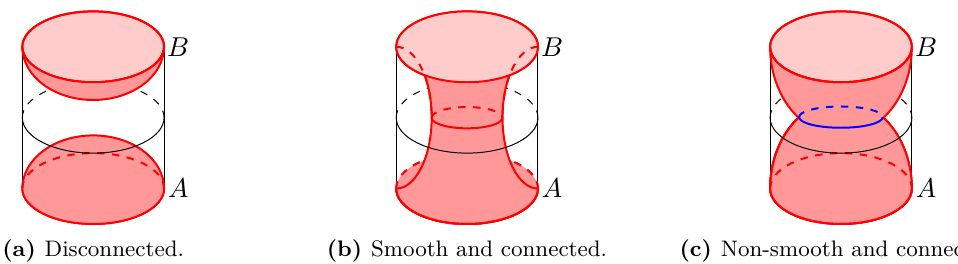
Figure 1. Possible brane configurations for the holographic dual to a BCFT state on a cylinder. A and B represent possible conformal boundary conditions at each connected component of the boundary. Figure 1c in particular represents a non-smooth merging of two different